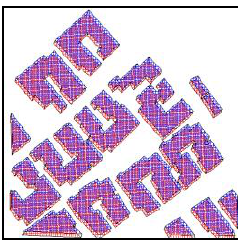
Figure 8: the modeling results